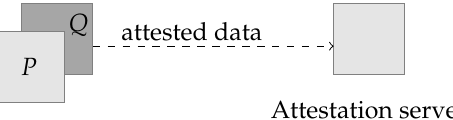
Figure 5. C-FLAT architecture.